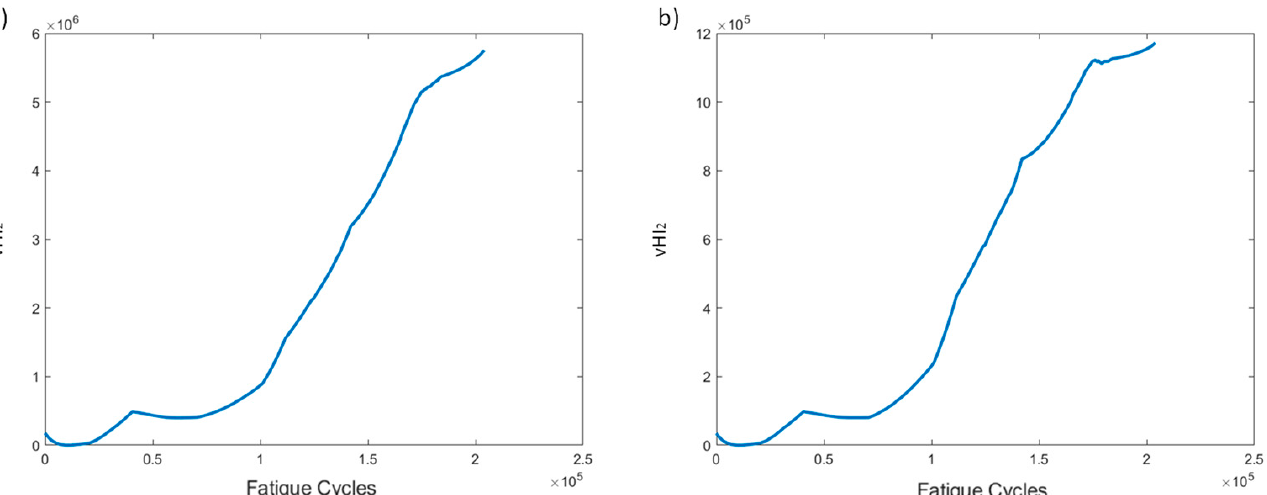
Figure 18. vHI 1 progression through time for the two pre-processing methods for specimen VA-1: ( a ) method 1, ( b ) method 2.